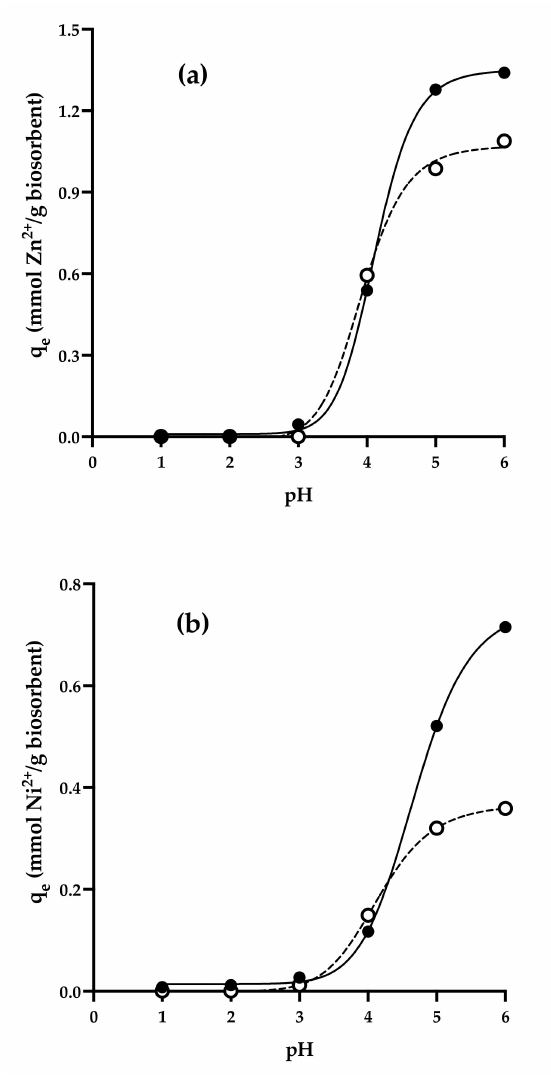
Figure 1. Effect of solution pH on the biosorption of ( a ) Zn 2+ and ( b ) Ni 2+ ions by CS in single ( • ) and binary ( ◦ ) metal systems. Conditions: Biosorbent concentration, 1 g/L; temperature, 25 ◦ C; initial metal concentration, 2 mM. The error bars represent the standard deviation from the mean, and it should be noted that the majority of error bars were smaller than the symbols, and so could not be